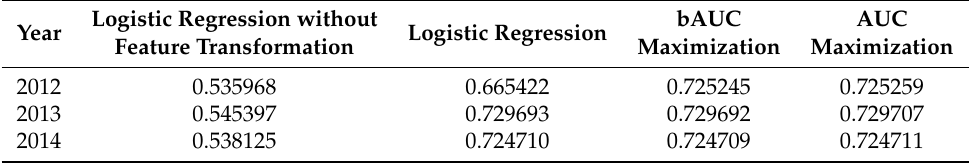
Table 2. Results for models with one feature—DTI.